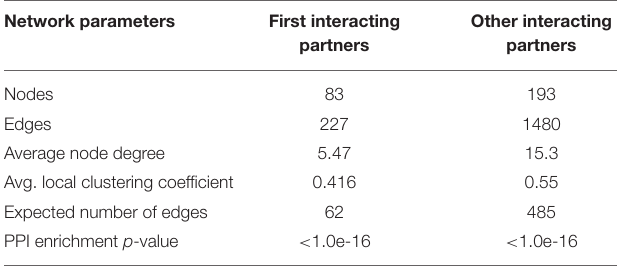
TABLE 3 | Network statistics of protein-protein interaction. Network